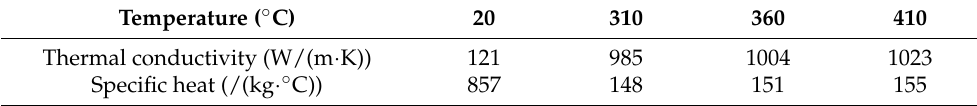
Figure 14. Finite element model of automobile S-rail hot stamping. Table 2. Thermal properties of 7075 aluminum